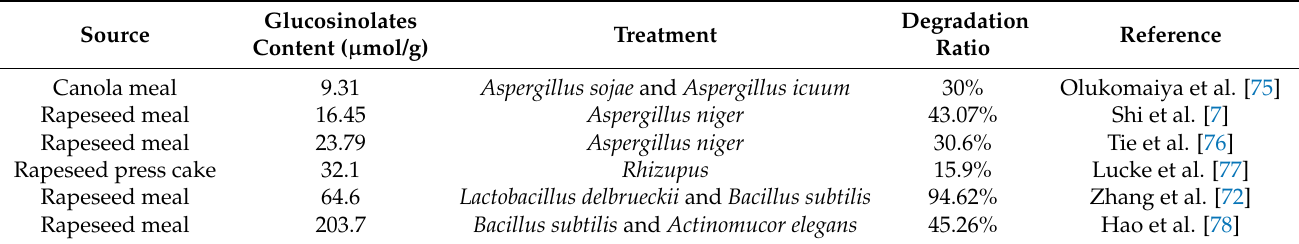
Table 3. Effects of microbiological fermentation on glucosinolates in rapeseed meal.